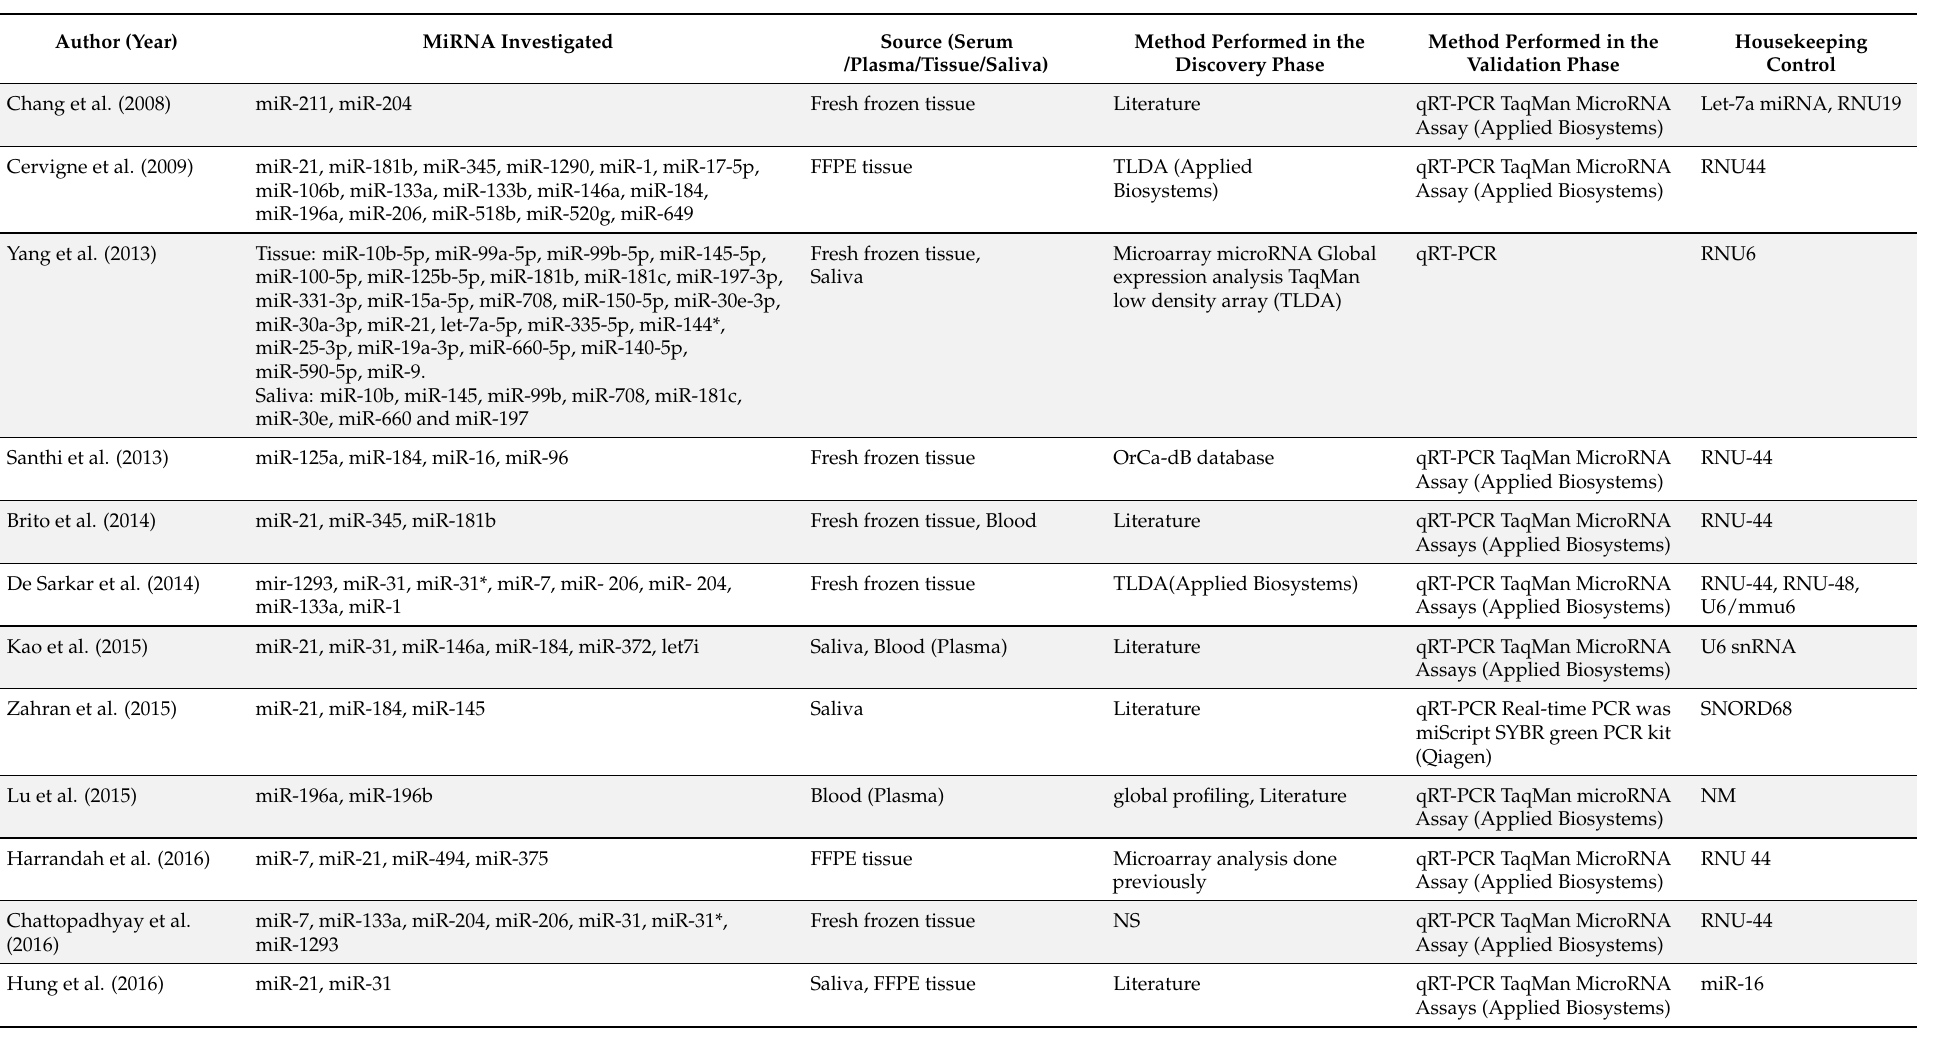
Table 3. Methodology used in the included